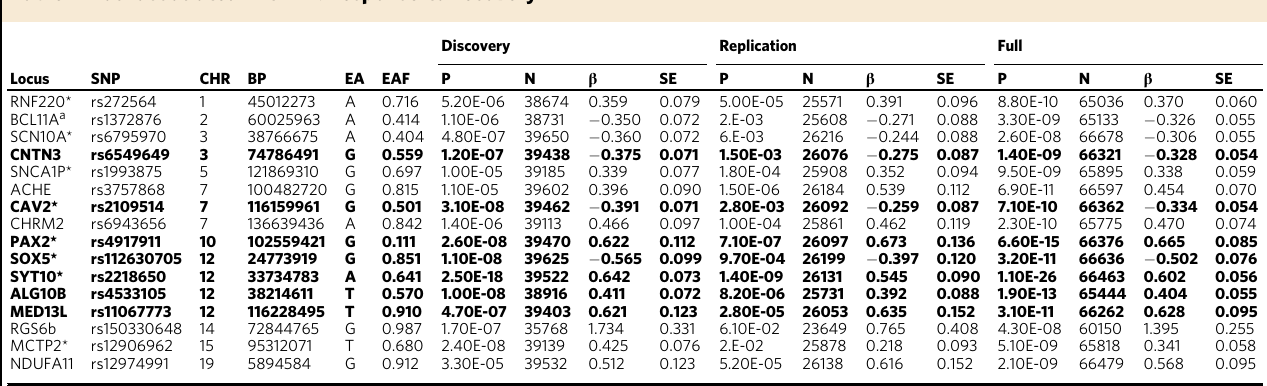
Table 2 Loci associated with HR response to recovery